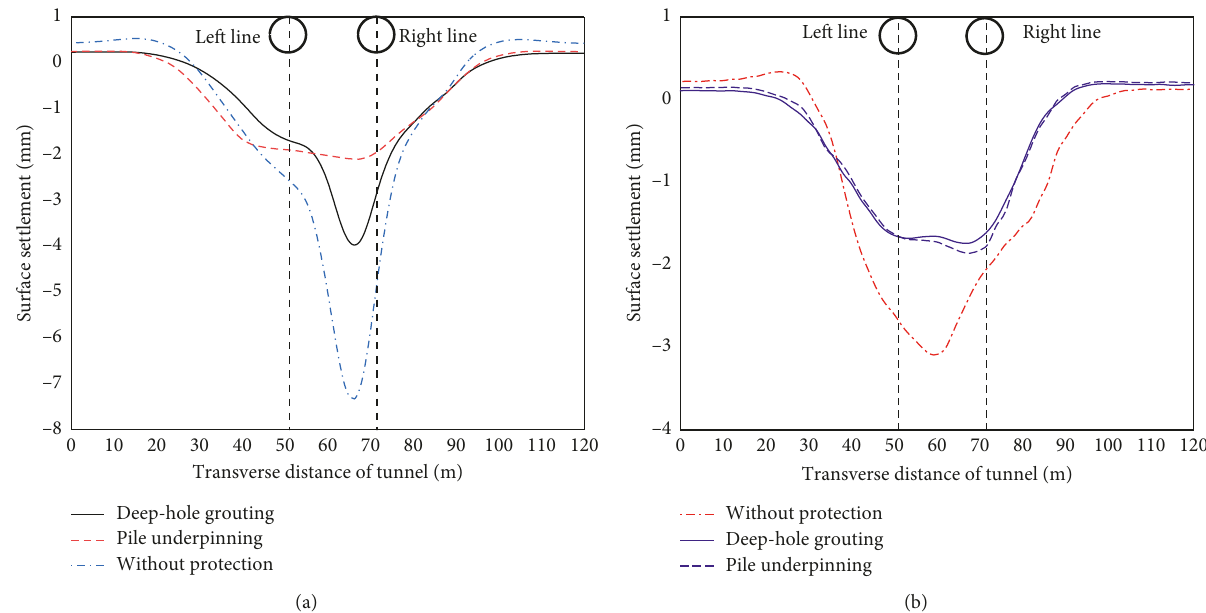
Figure 13: Ground settlement curves of different schemes: (a) Y � 42m; (b) Y �